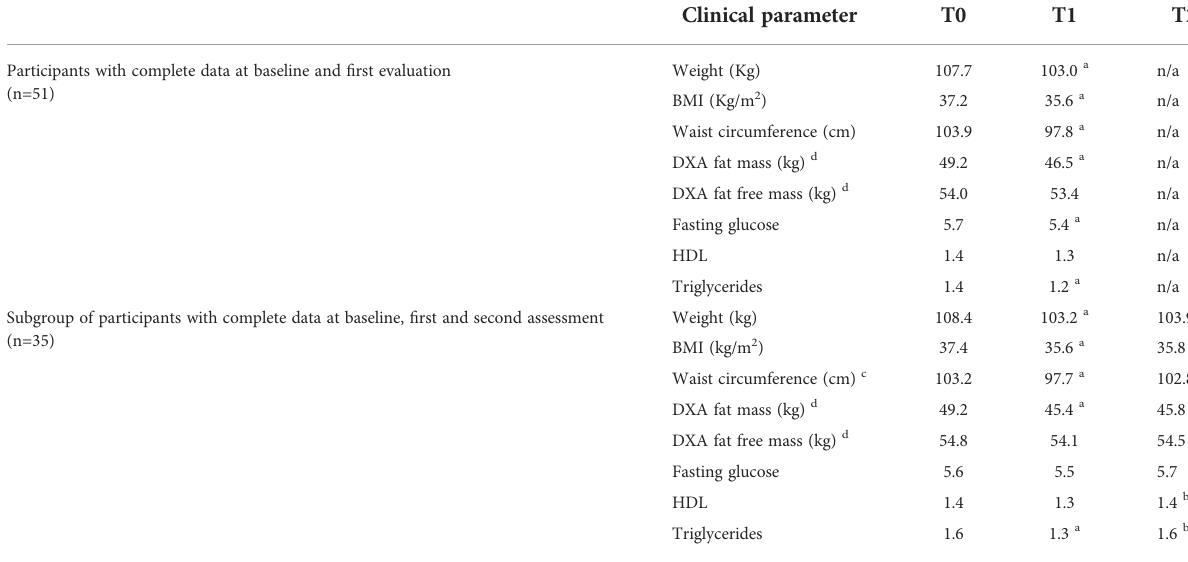
TABLE 4 Clinical parameters before, during and after a combined lifestyle intervention.